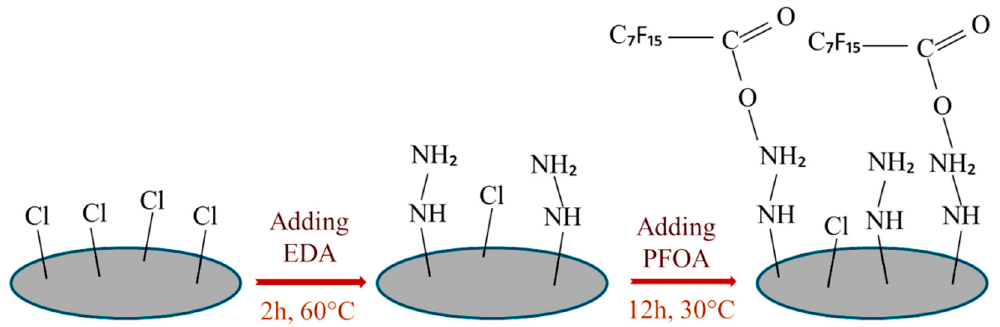
Figure 4. Schematic illustration of surface modification of PVC fluorinated membrane (inspired from [65]). Antifouling and high-flux (~46.1 L/(m 2 h)) polydopamine (PDA) membranes were developed